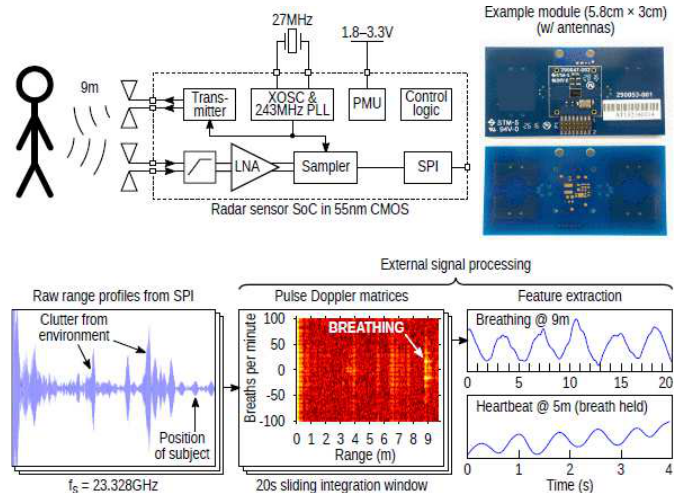
Figure 2. System overview and real-life application example with measured performance [102]. LNA, linear